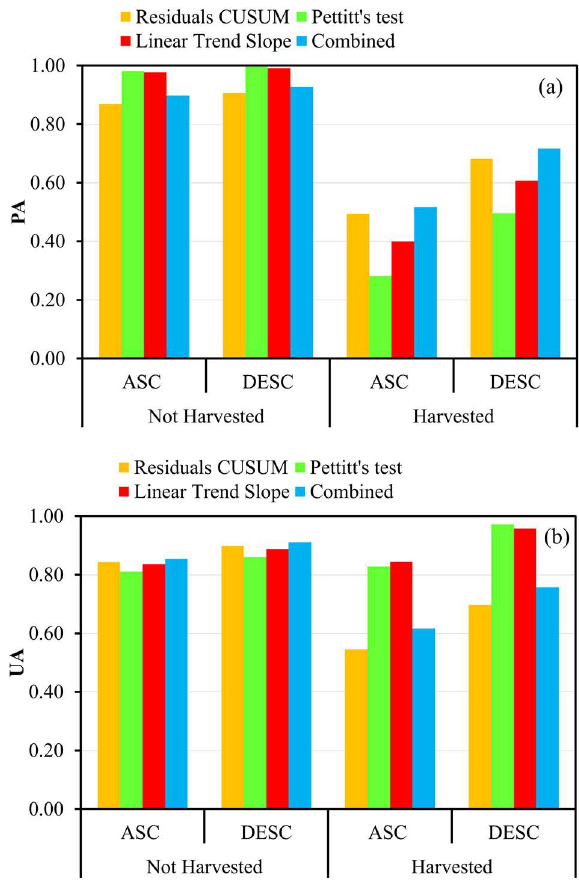
Figure 10 . (a) PA and (b) UA values resulting from different forest harvesting classifications in respect to RD.